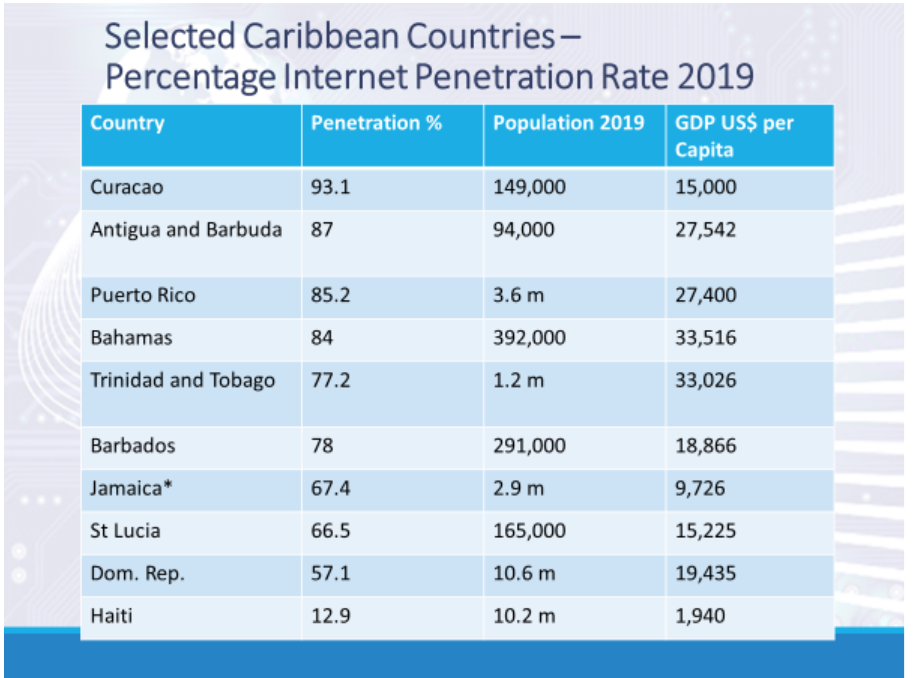
Figure 2. Selected Caribbean countries: Percentage of internet penetration rates in 2019. Data from Dunn (2016), Internet World Stats (2020) and the